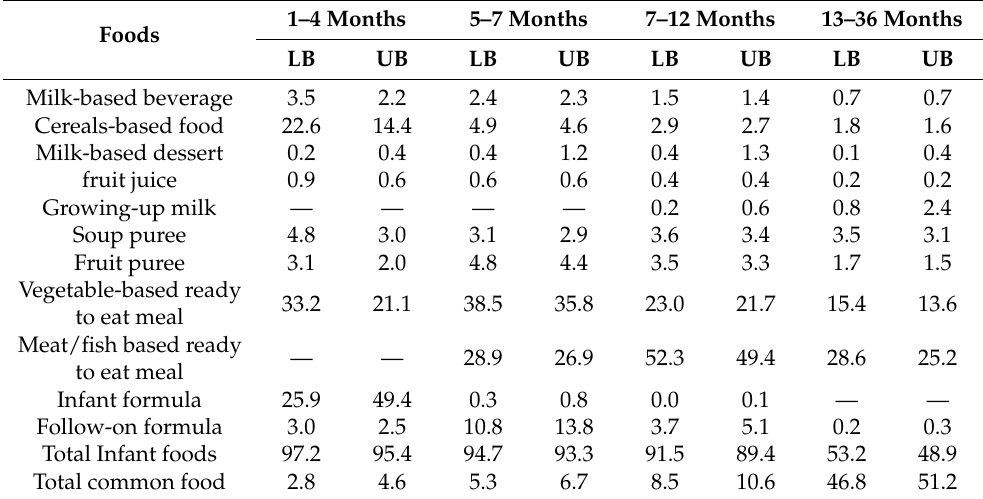
Table 2. Contribution of different foods to the LW and UB exposure to furan. Data source: Sirot et al.,